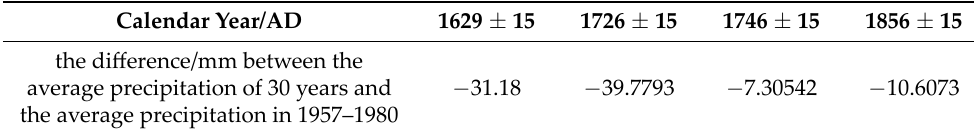
Table 2. Annual average precipitation of studied time section.